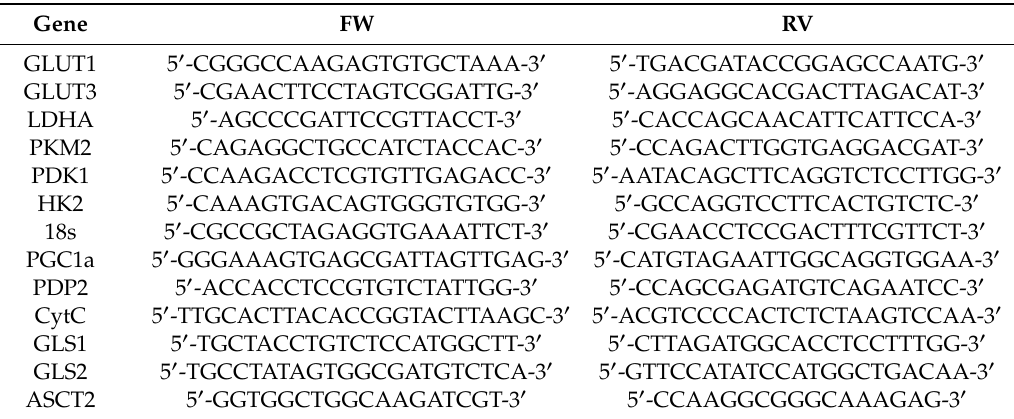
Table 1. Primer sequences used for